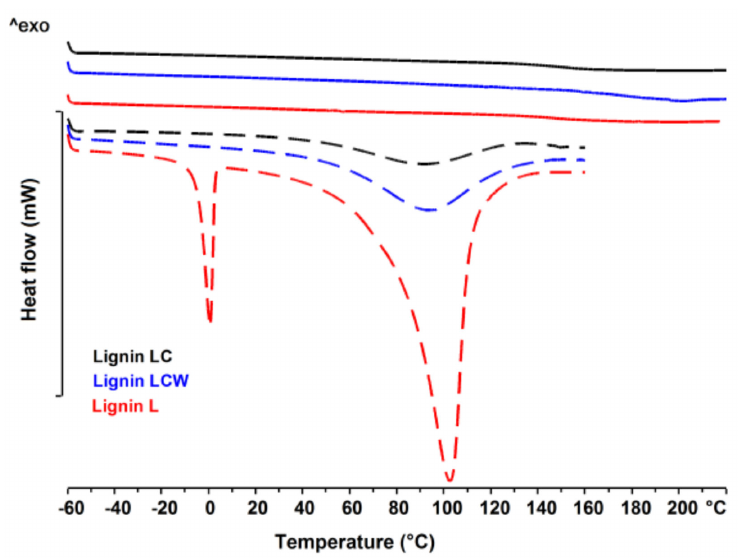
Figure 12. DSC curves of various lignin; 1st heating (dotted line) and 2nd heating (solid line).